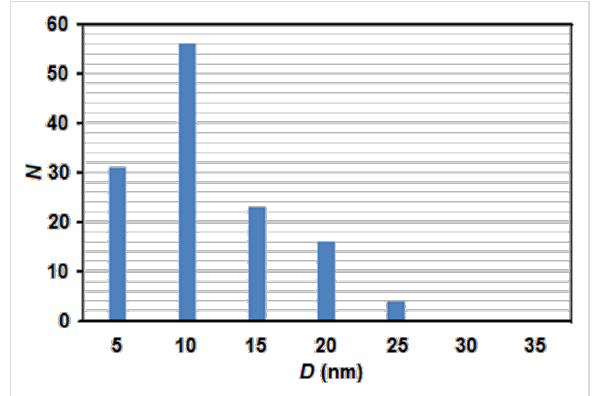
Figure 6: Size distribution of the Ge nanoparticles in region II of the laser transformed layer. The distribution is made from 130 nanoparti- cles counted on STEM images in which the Ge content is revealed by the Z -contrast. The average size is 11.5 nm.